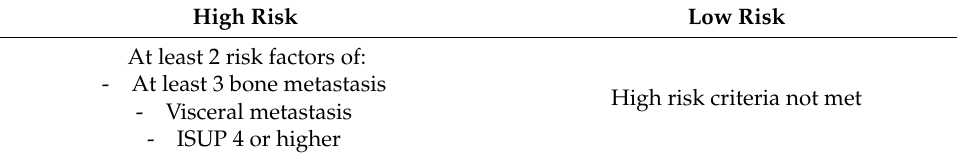
Table 2. LATITUDE Criteria